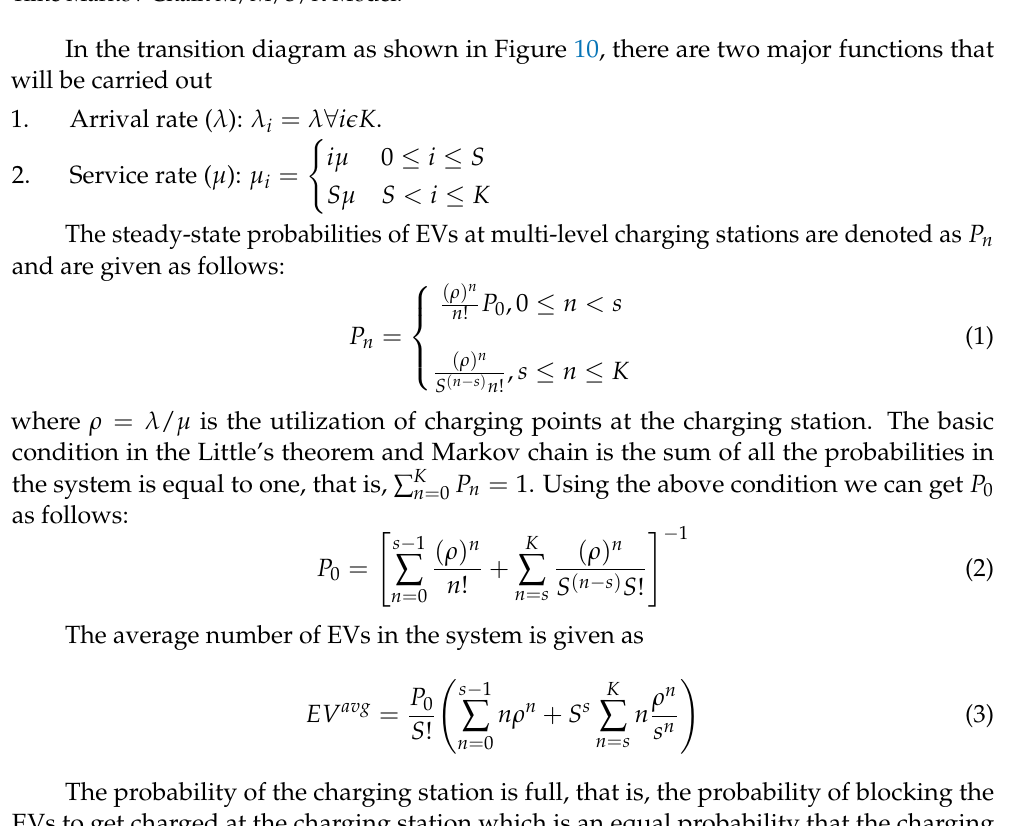
Figure 10. Stochastic EVs queuing model at Multi-level Charging Station Infrastructure: Discrete Time Markov Chain M / M / S / K